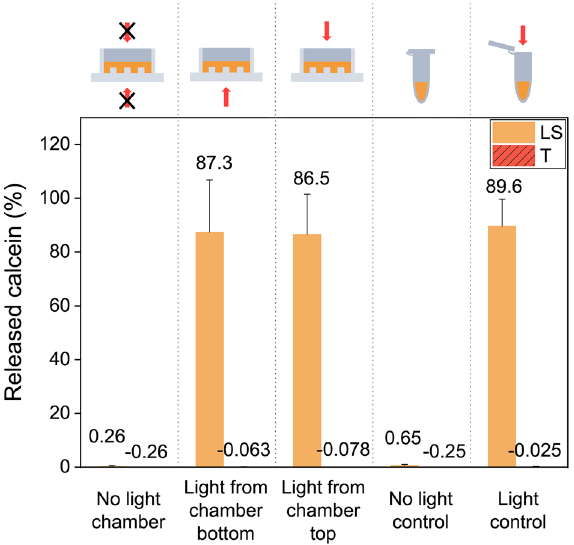
Figure 1. Calcein release from light-sensitive (LS) and traditional liposomes (T). For non-irradiated control samples, the calcein release was measured when the liposomal samples were stored within chambers (+ 37 °C) and in Eppendorf tubes (+ 4 °C). For the irradiated samples, the irradiation was performed from the bottom of the chamber (through the chamber material, + 37 °C), from the top of the chamber (without chamber lid on, + 37 °C), and the “light control” was irradiated within Eppendorf tubes, as previously described 27 . Mean ± s.d., n =